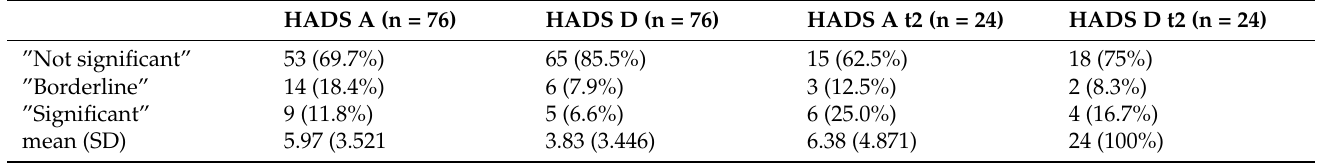
Table 2. Overview of the results of the HADS questionnaire.